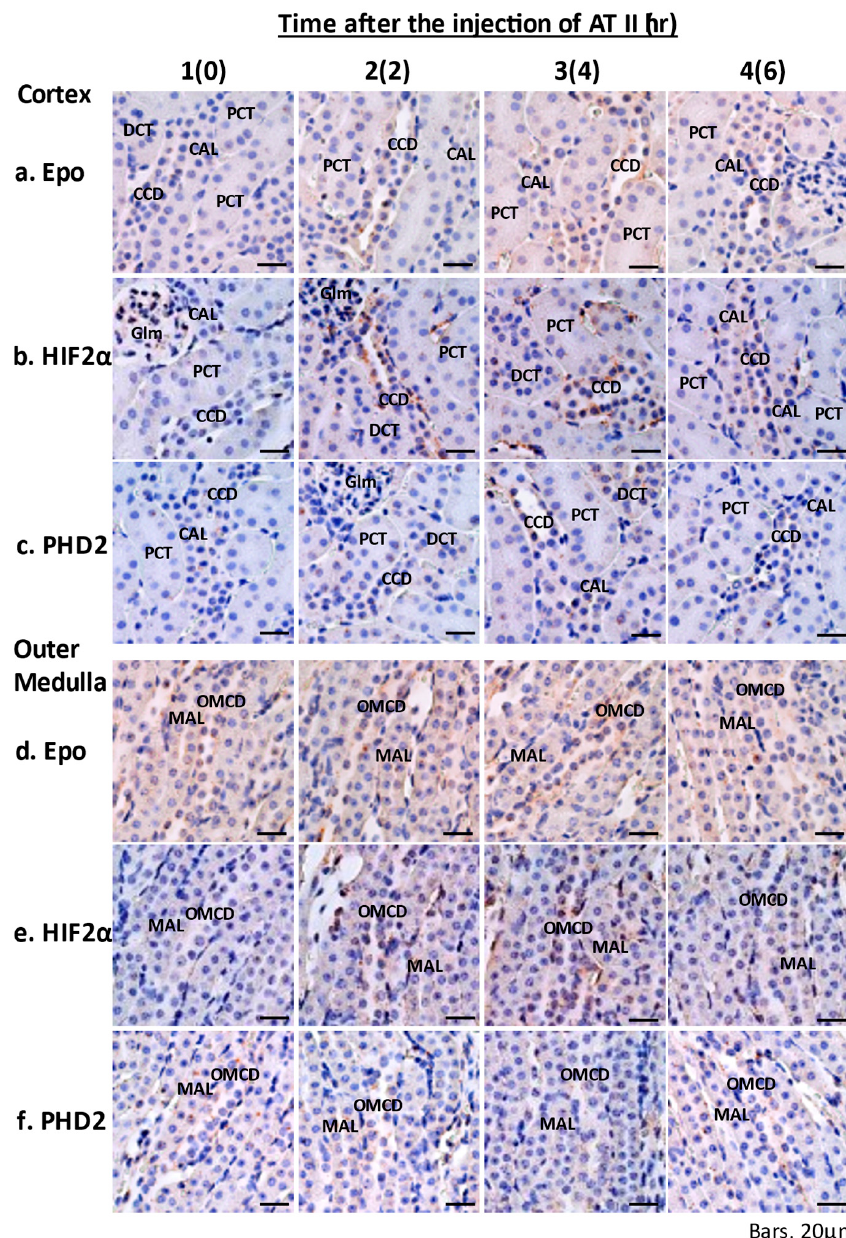
Figure 2. Effects of ATII on Epo mRNA expression evaluated by ISH. In situ hybridization was used to analyze the effects of ATII on Epo, HIF2 α , and PHD2 mRNA expression in mouse kidneys.